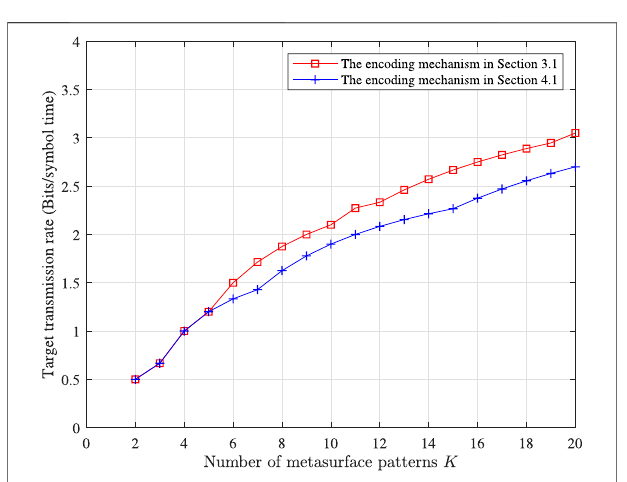
FIGURE3 | Trend ofthetarget transmissionrate alongwiththe increase in the number of metasurface patterns.